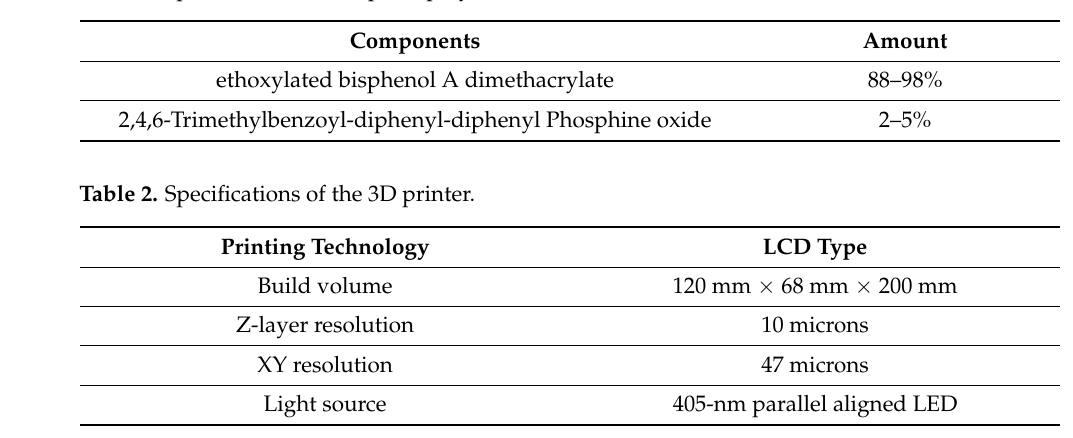
Table 1. Specifications of the photopolymer resin.